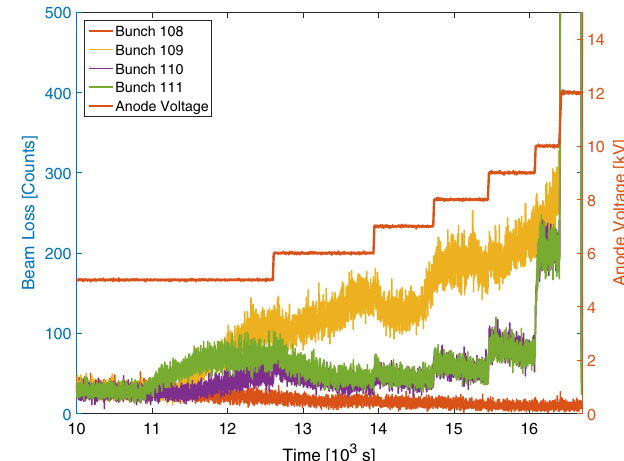
FIG. 15. Anode modulator signals and ion beam intensity during the parasitic mode. FIG. 16. Alignment and collision with the last several